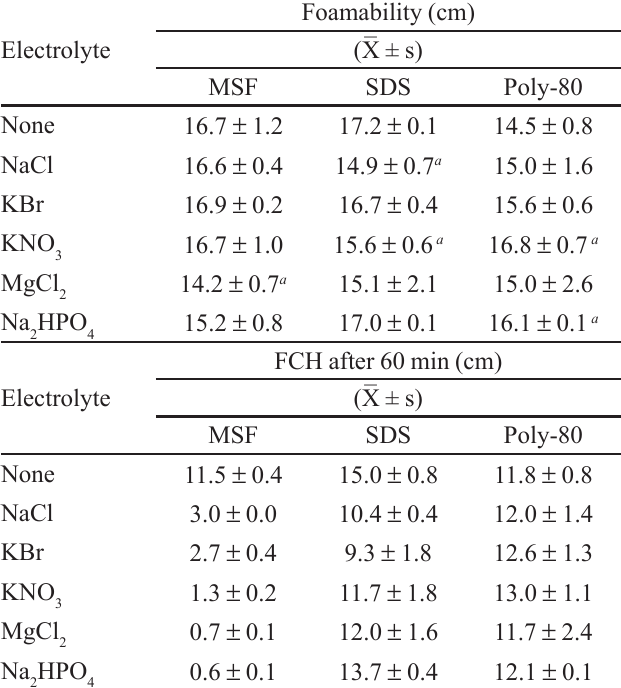
TABLE III - Results of addition of electrolytes ( I = 0.024 M) on foamability and foam column height (FCH) after 60 min for mate saponin fraction (MSF), sodium dodecyl sulfate (SDS), and polysorbate 80 (Poly-80) solutions